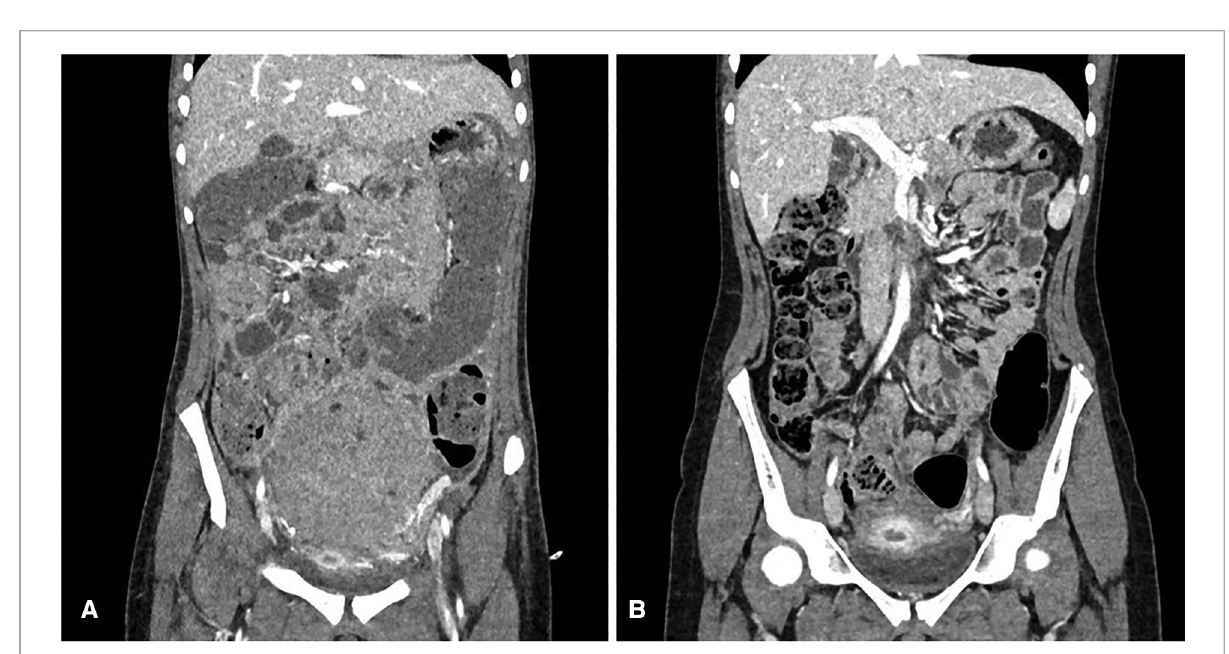
FIGURE 3 Histological aspect (Hematoxylin and Eosin stained